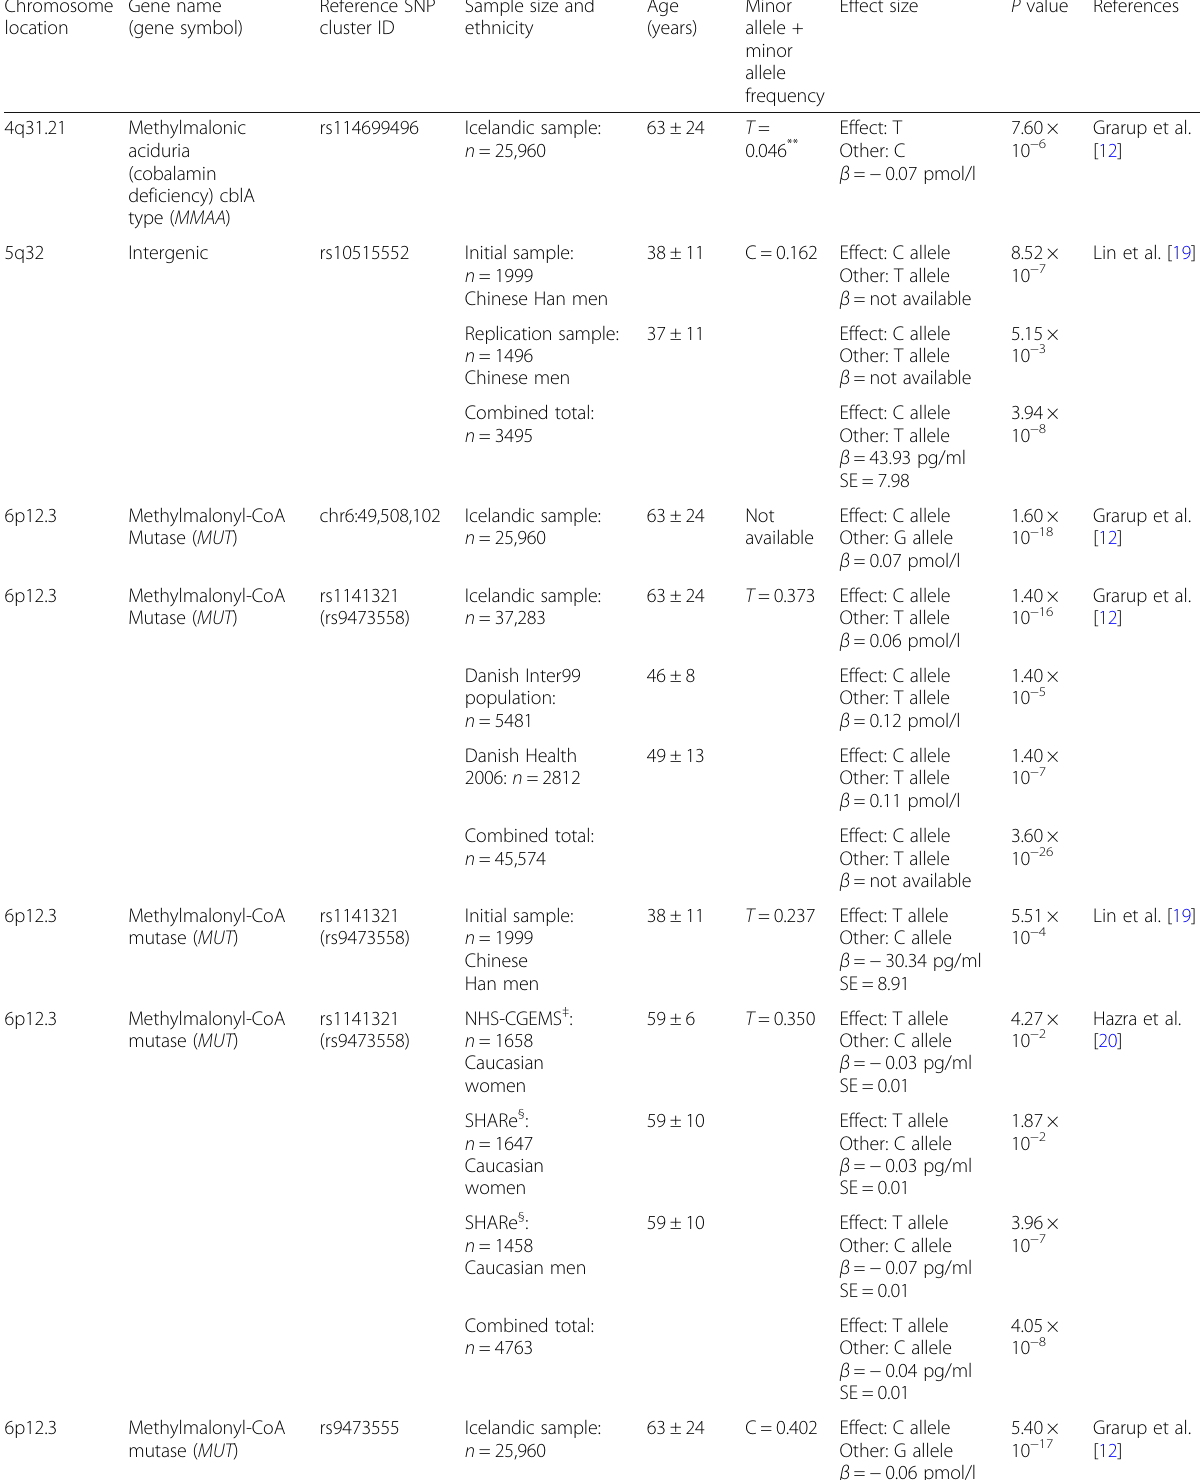
Table 1 Genome-wide association studies showing the association of SNPs with vitamin B12 concentrations. Genome-wide association studies testing the association between SNPs and vitamin B12 concentrations. The chromosome location, gene name, reference SNP cluster ID, sample size and ethnicity, mean age, observed frequency of the minor allele in the population, effect size and P value are shown in the table. The order of SNPs reflects the order of the chromosome location